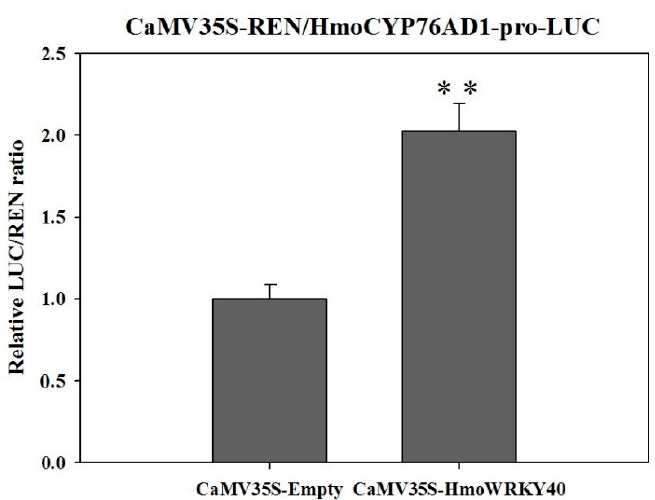
Figure 8. HmoWRKY40 activated the transcriptions of HmoCYP76AD1. The activation was measured as a ratio of LUC to REN. The ratio of LUC/REN of the empty vector plus promoter was used as the calibrator (set as 1). Three independent experiments were conducted (n = 3). The error bars indicate one standard error. Significant differences from CaMV35S-Empty were determined according to Student’s t -test (** indicates p < 0.01).